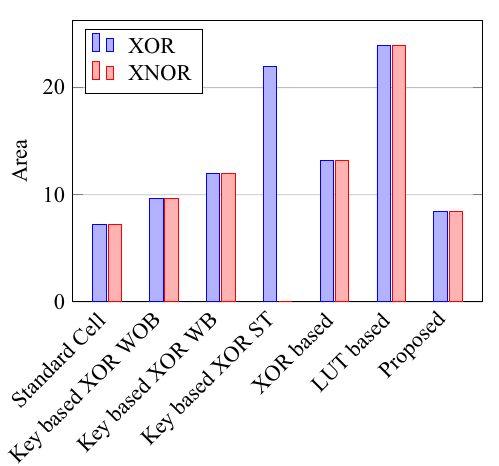
Figure 35. Area for XOR and XNOR gates.